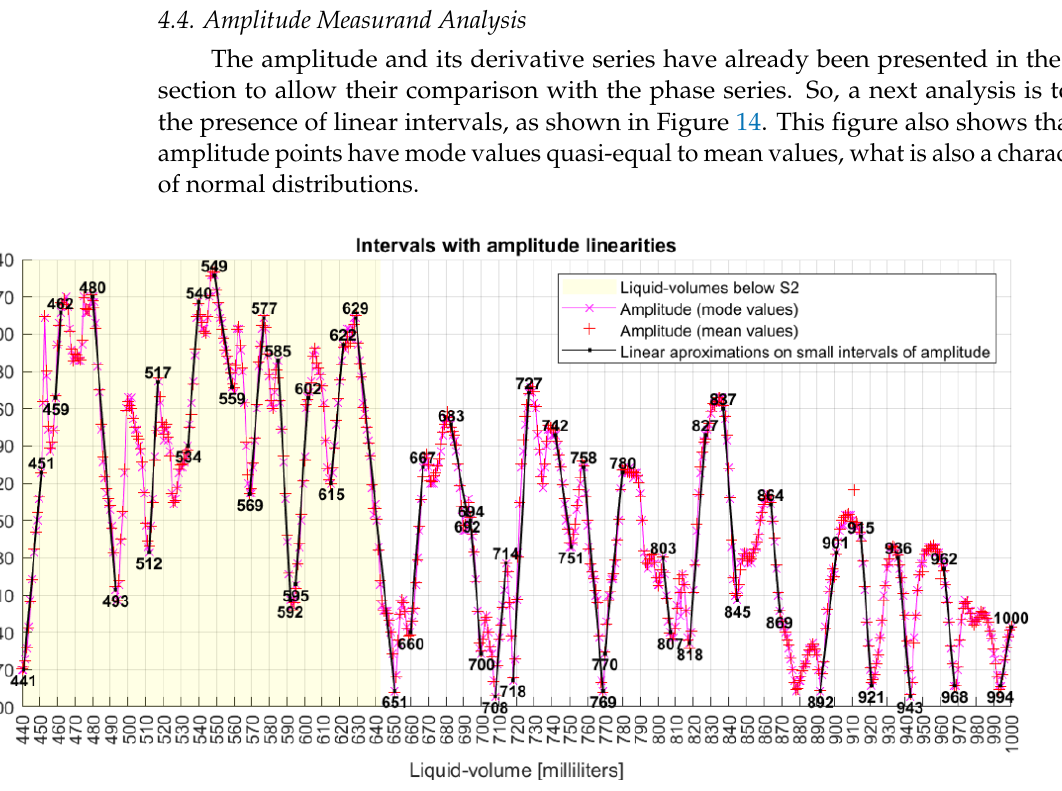
Figure 15. Liquid volumes with linear intervals on the derivative of amplitude series. The amplitude analysis shows that the collected data are nonlinear, and it is not obvious how to derive a math function to fit these data. In this sense, the next section presents an analysis using both phase and amplitude mode points. 4.5. Phase and Amplitude Analysis This topic evaluates both amplitude and phase as coordinates of a 2D Cartesian space. Figure 16 uses the corrected phases previously presented in Figure 7, and Figure 17 uses the unwrapped phases presented in Figure 13. Both graphs have the phase measurand in the x -axis and the amplitude measurand in the y-axis, with point coordinates defined by their mode values. The integer numbers plotted over the sequenced points are the